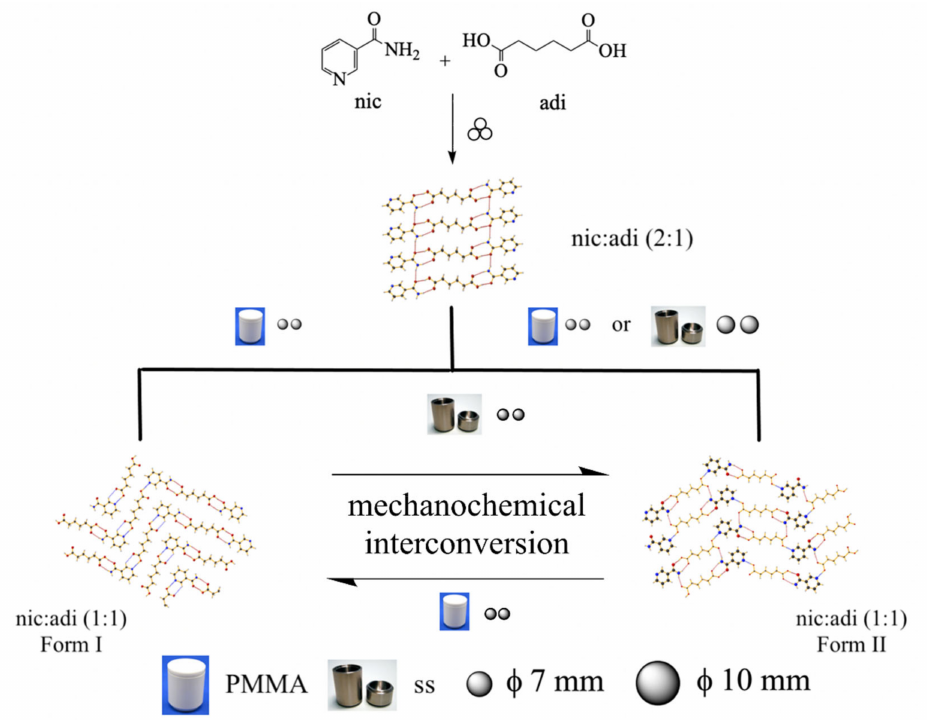
Figure 9. Schematic representation of the different solid forms in the cocrystal system nic:adi. These processes can be controlled by the choice of milling assembly. Adapted with permission from [229], Royal Society of Chemistry,